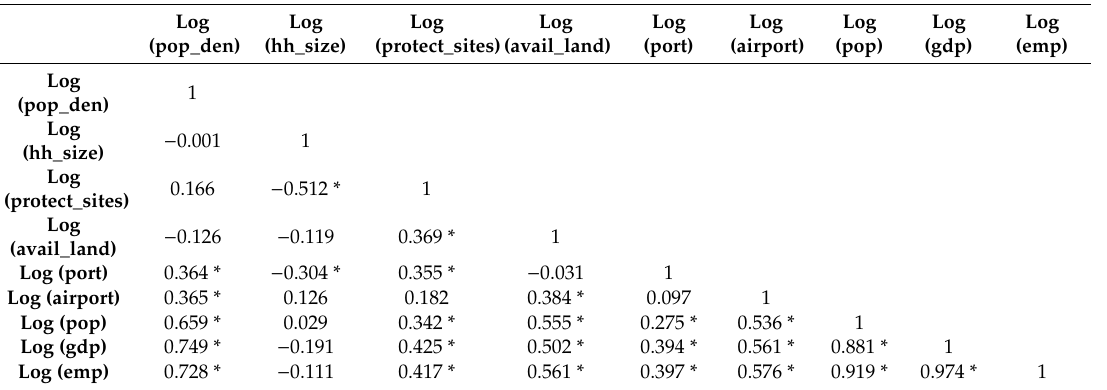
Table A2. Correlation coe ffi cient matrix (variables explaining residential land